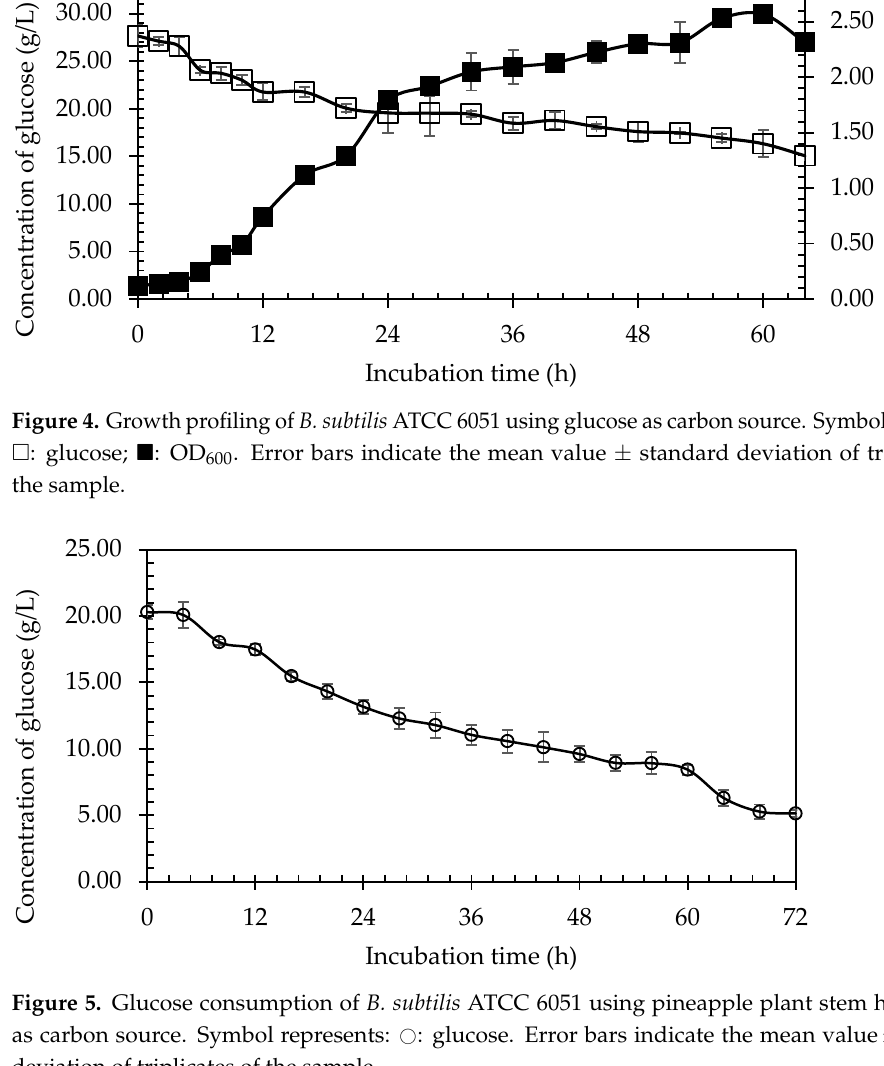
Table 2. Maximum increment in amino acids production from pineapple plant stem hydrolysate through separate enzymatic hydrolysis and fermentation using B. subtilis ATCC 6051. Superscripts with different letter are significantly different from each other within the same column at p ≤ 0.05.